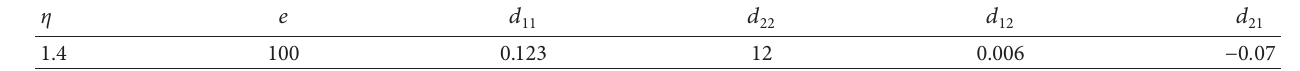
Table 4: Parameters set in system (4).